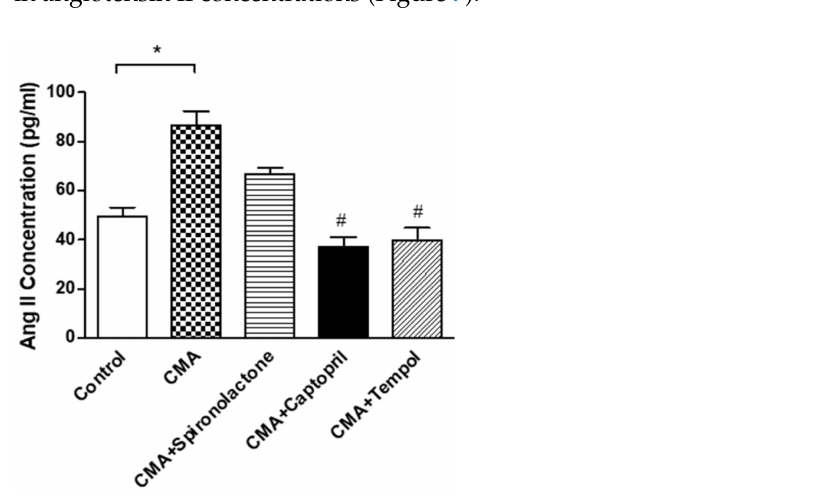
Figure 7. Interstitial fluid analysis for Angiotensin II concentration. Each bar represents values ex- pressed as mean ± SEM. The changes in interstitial Ang II concentrations were considered significant when * p < 0.05 (control vs. CMA) groups and # p < 0.05 (CMA vs. CMA + captopril or CMA + tempol) groups. The data were analyzed using one-way ANOVA followed by Tukey’s multiple comparison test among all five groups.